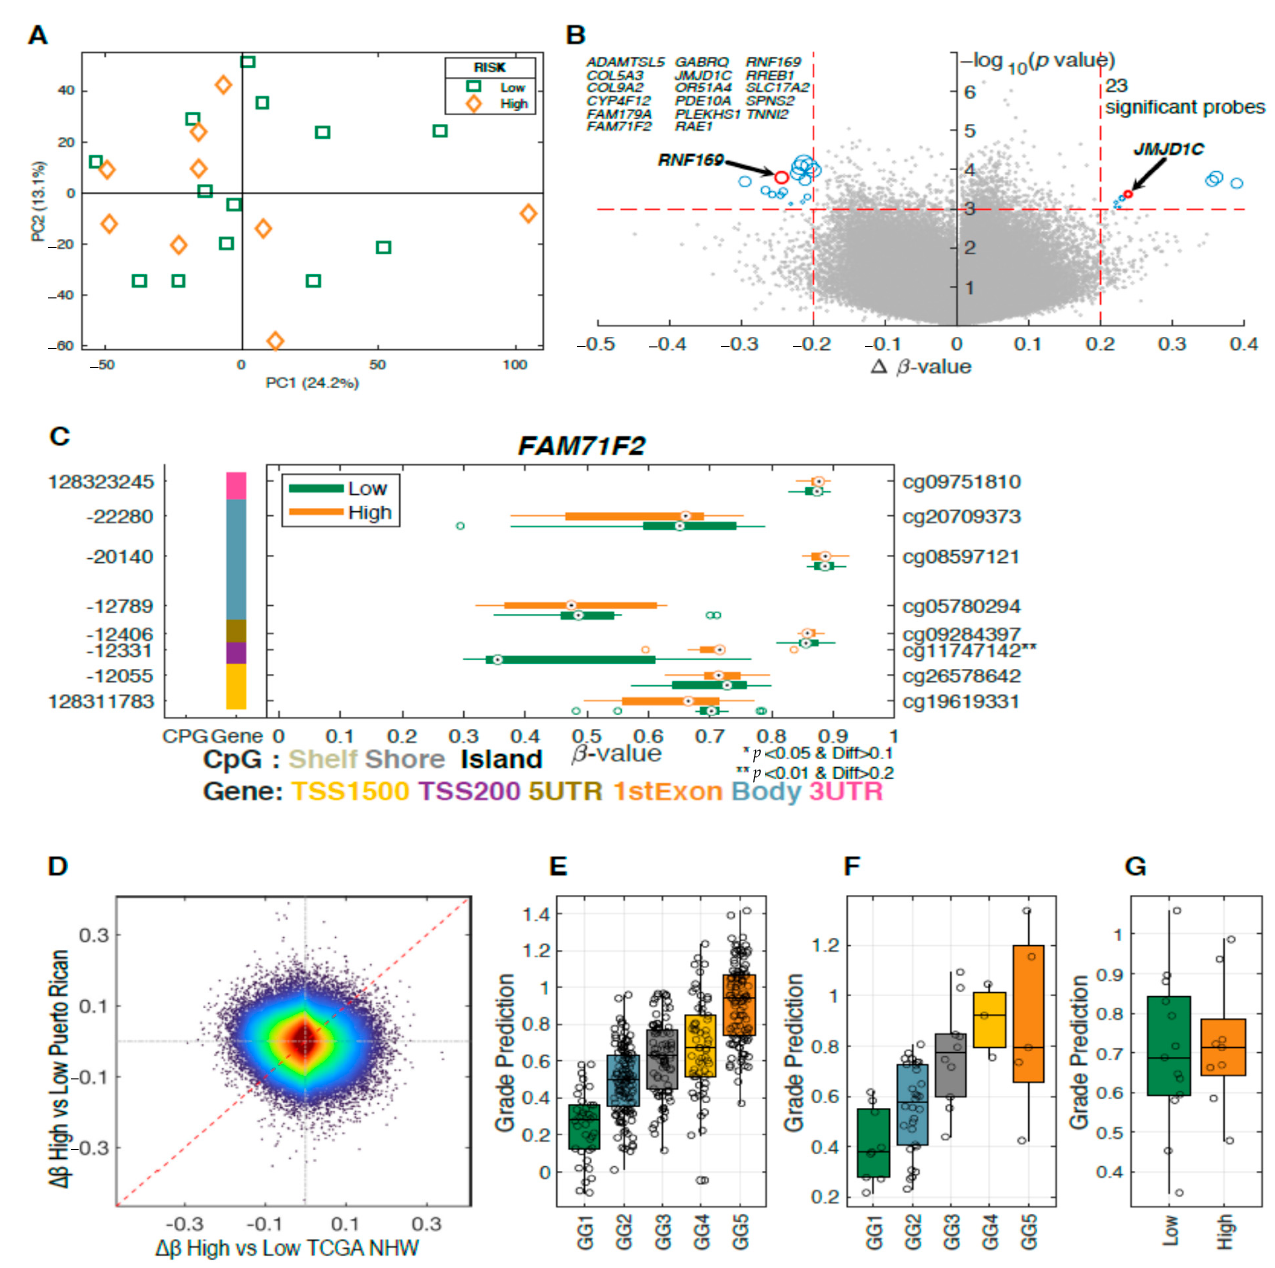
Figure 2. Methylation differences in high-grade vs. low-grade prostate tumors. ( A ) PCA of 22 samples in our study shows no separation between low-risk (green rectangles, n = 13) and high-risk (orange diamonds, n = 9) groups. ( B ) Volcano plots highlighting 23 differentially methylated sites between high-risk and low-risk prostate tumors with a − log 10 p -value on the y -axis and ∆ β -value on the x -axis. ( C ) GSM plot for FAM71F2 demonstrating lower level of methylation for the low-risk group compared to the high-risk group for cg11747142. ( D ) Density scatter plot comparing the ∆ β -value for GG1 vs. GG5 for the TCGA PRAD NHW samples compared to the ∆ β -value for the high-risk vs. low risk Puerto Rican samples. Prediction results for a PLS model derived using ( E) TCGA PRAD NHW GG1 vs. GG5 applied to the TCGA NHW samples, ( F ) TCGA non-Hispanic Black (NHB) samples, and ( G ) Puerto Rican